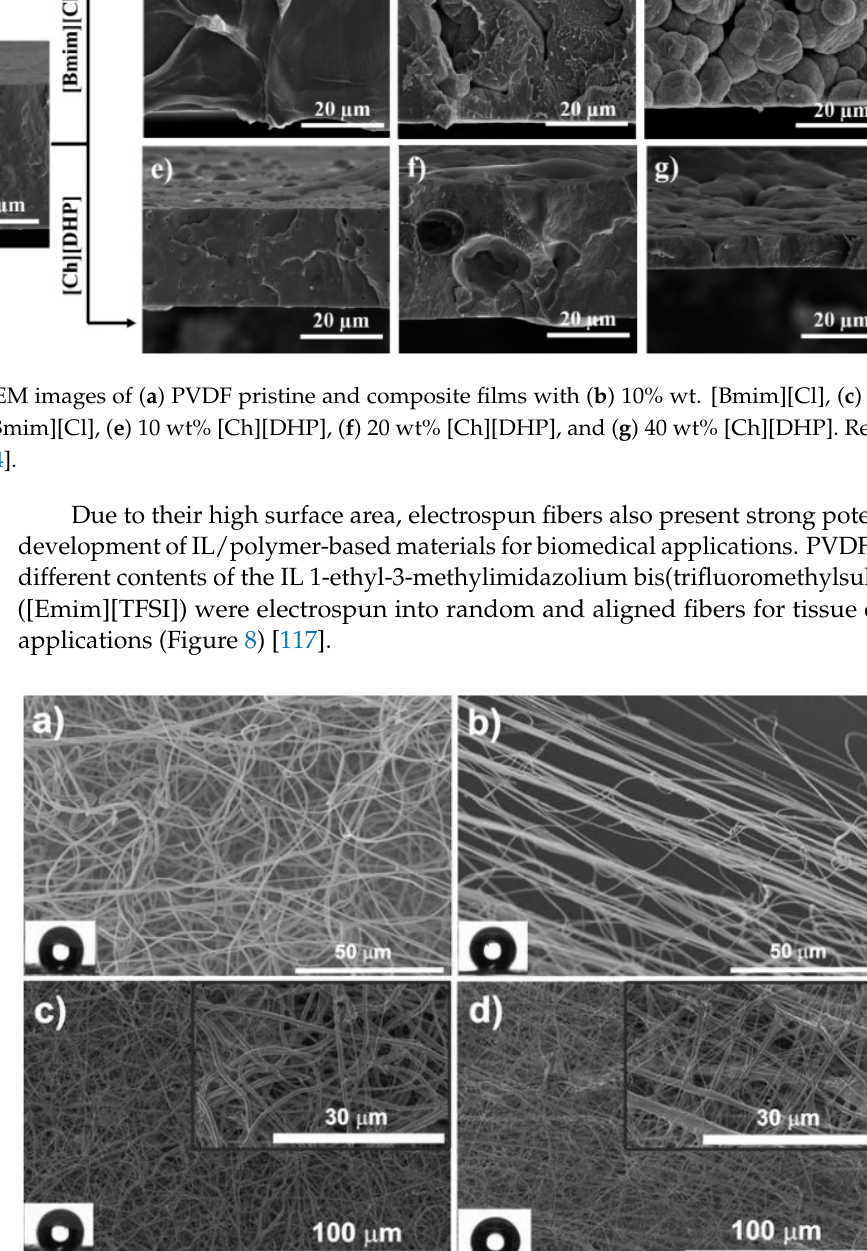
Figure 9. Applications of ILs in drug delivery systems design and development (APIs: active phar- maceuticals ingredients). Reprinted with permission from [118]. Table 1 reports the main works using IL-based materials for drug delivery applica- tions, presenting the used materials, the target application, as well as the main obtained results.